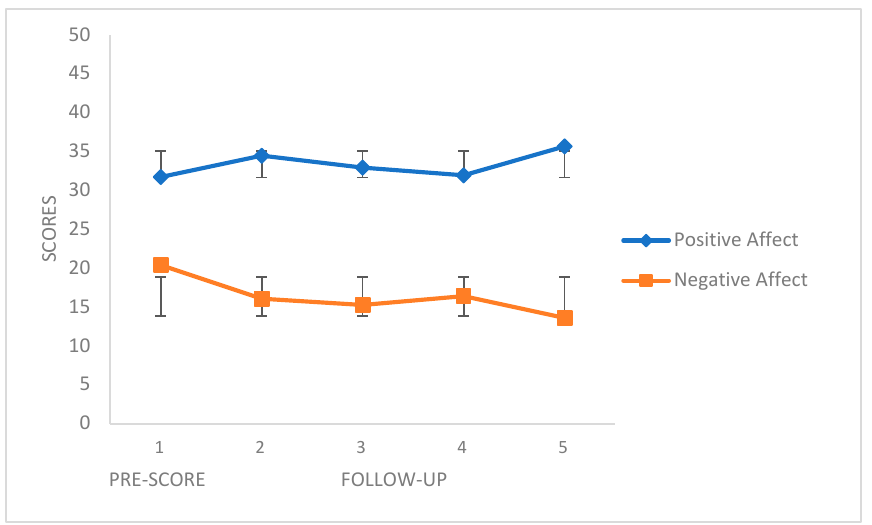
Figure 4 PANAS variables in the follow-up. Mean values (SD). Figure 4. PANAS variables in the follow-up. Mean values